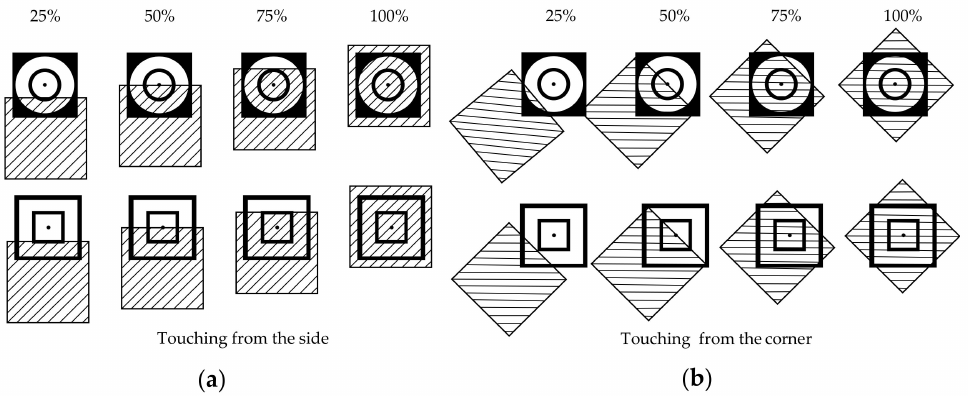
Figure 4. The active area of the circle and square electrode tactile sensors: ( a ) when touching the object at 25%, 50%, 75%, and 100% from the side; ( b ) when touching the object at 25%, 50%, 75%, and 100% from the